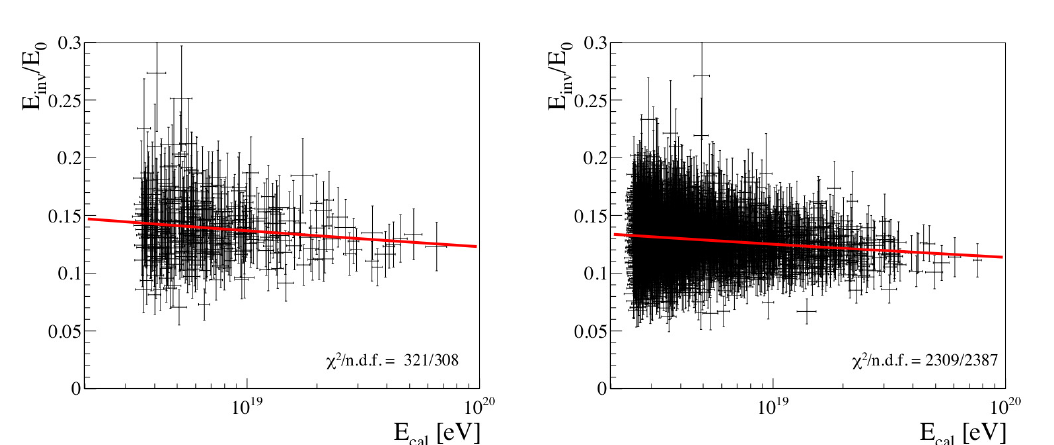
Figure 5. E inv as a function of E cal from the inclined (left) and vertical (right) hybrid events. Fitted function shown with red line. E 0